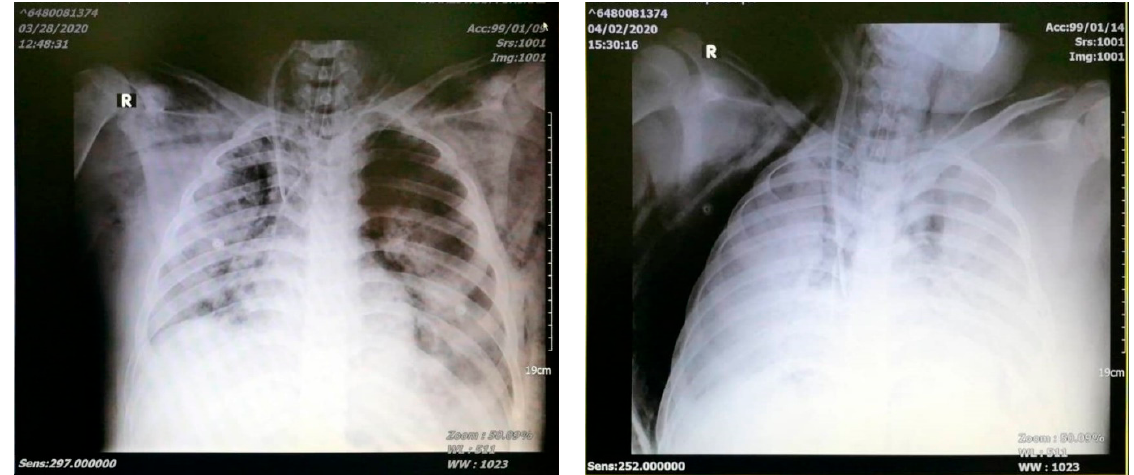
Figure 1. Chest X-ray on day 1 (left) and day 4 (right). Table 1. lab tests from day 1 to day 6 of admission.